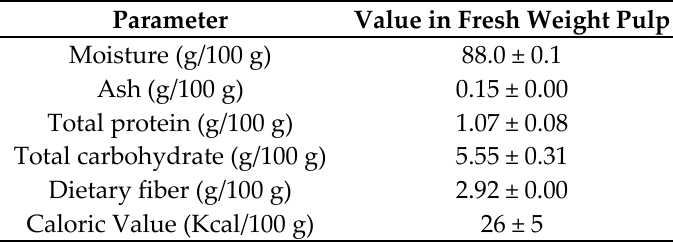
Table 2. Sicana odorifera ripe pulp